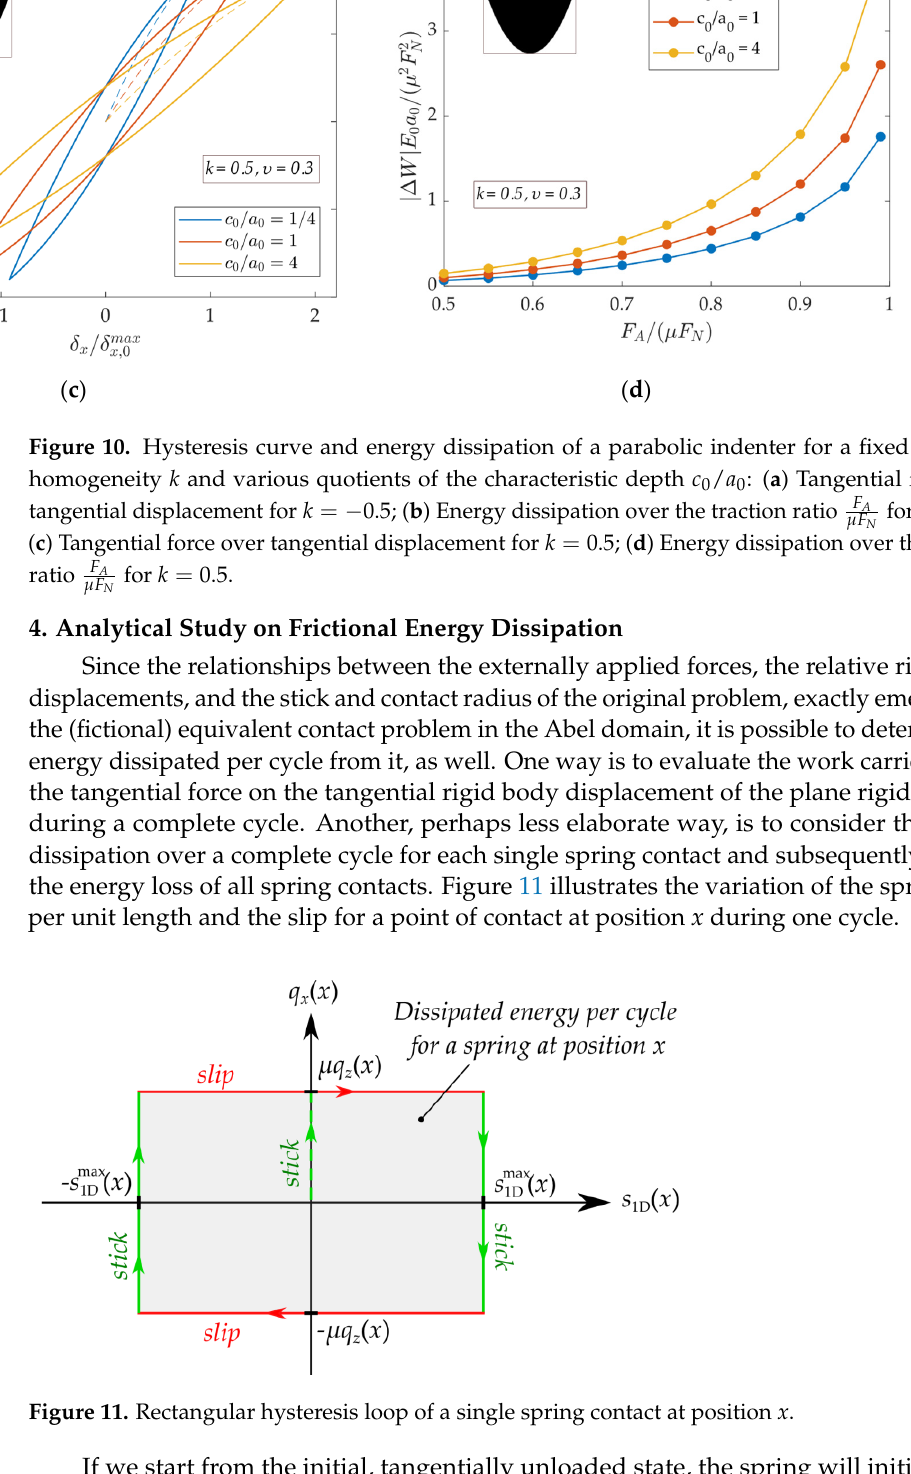
Figure 11. Rectangular hysteresis loop of a single spring contact at position x.